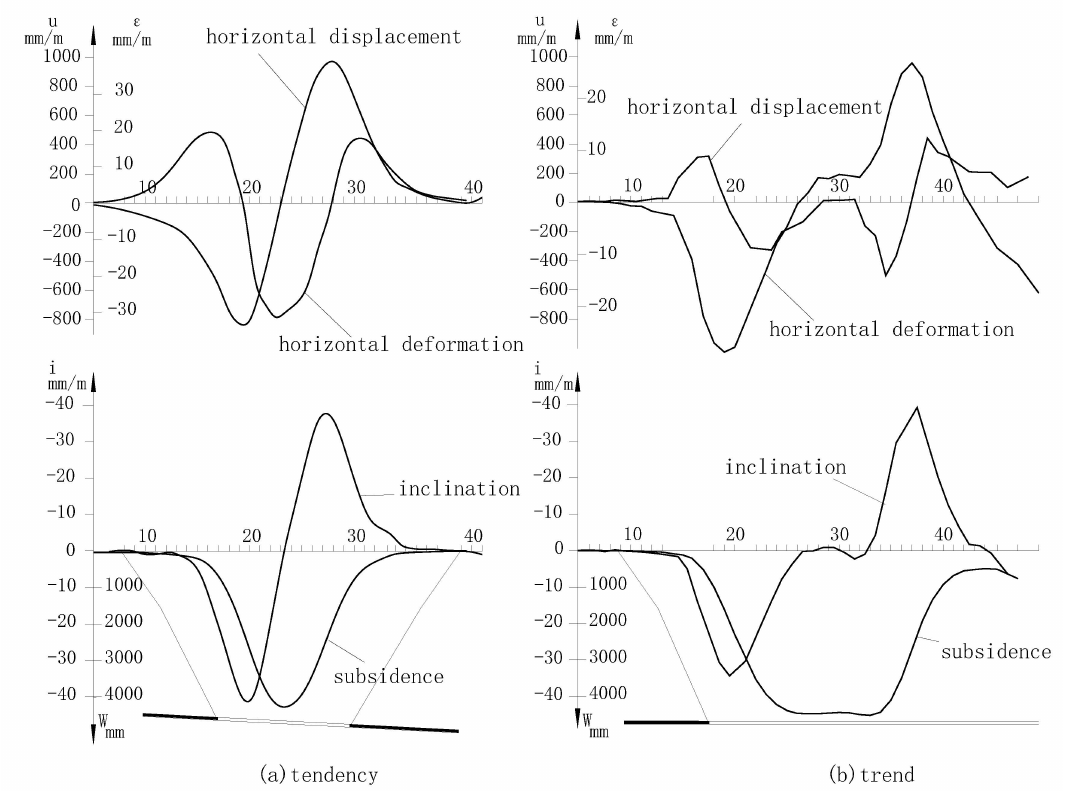
Figure 2. The deformation curve of the surface of the 6206 working face in Wangzhuang Coal Mine: ( a ) tendency, ( b )